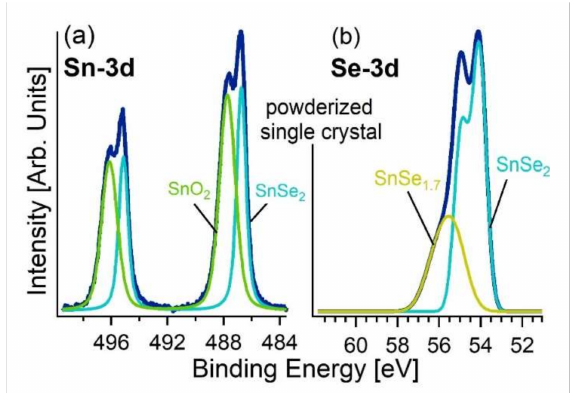
Figure 7. ( a ) Sn-3d and ( b ) Se-3d core levels of powderized SnSe 2 single crystal. Note that grinding of SnSe 2 bulk crystals was carried out in ambient atmosphere. The photon energy is 1486.6 eV (Al K α